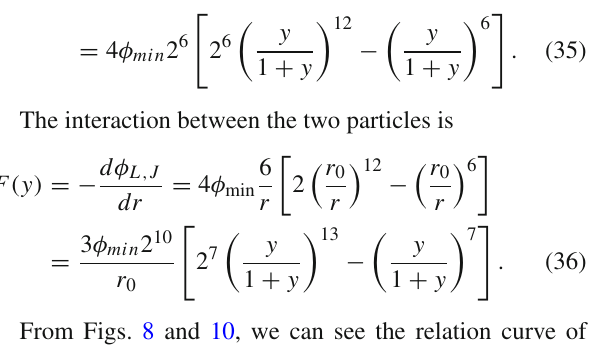
Fig. 9 φ L , J ( y ) − y diagram when y from 0 to